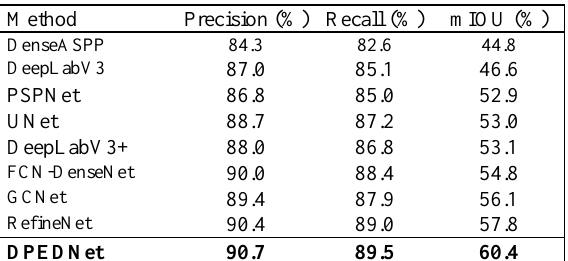
Table 1. Evaluation results on the CamVid test set.